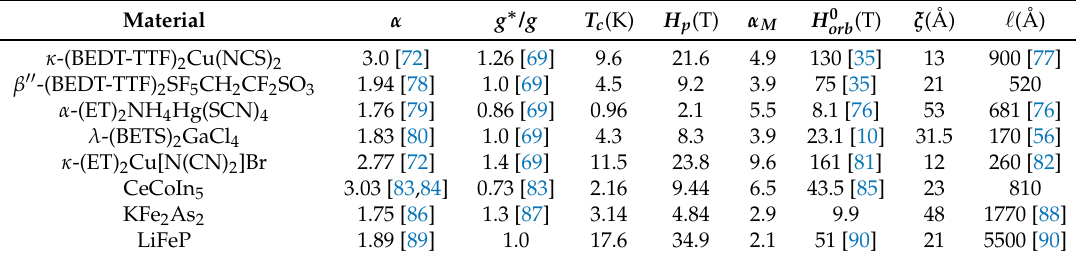
Table 1. Parameters that are useful in the study of inhomogeneous superconductivity. The ratio α is determined from the specific heat data in the reference next to α . The other parameters are calculated from values in the table or references. The T c values come from the specific heat data referenced for α .